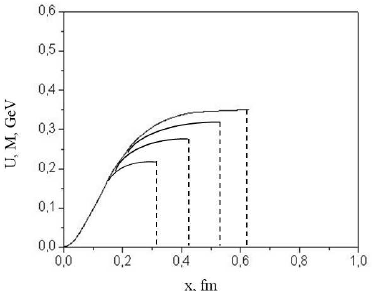
Figure 4. Modification of mass of con- stituent quark inside compressed